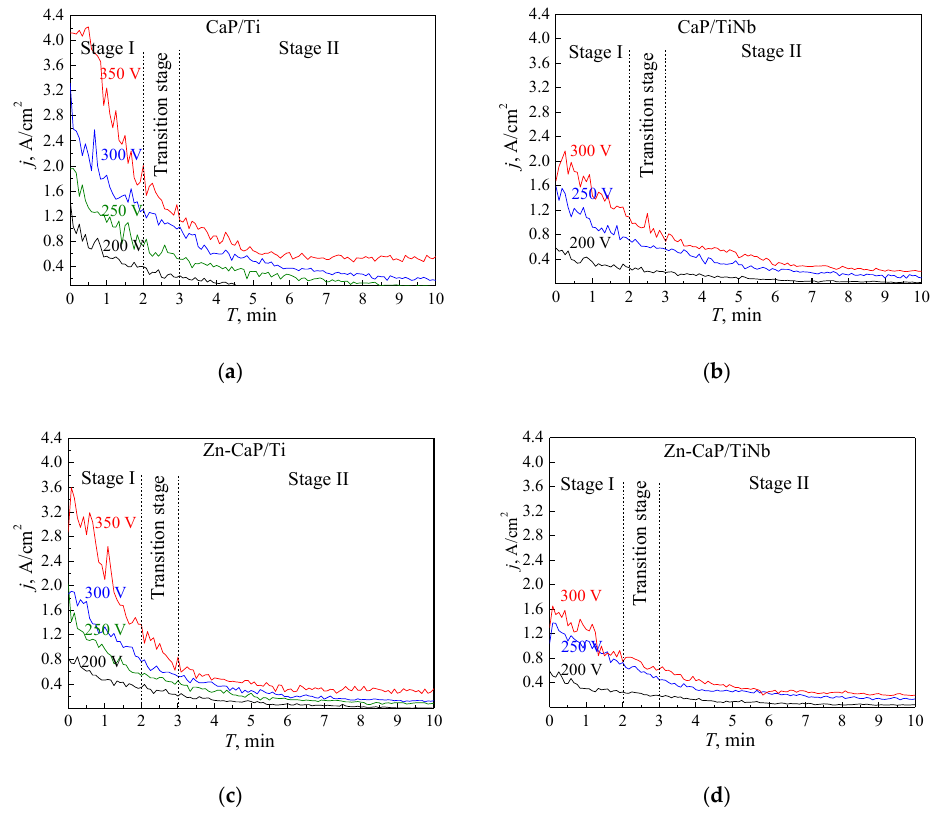
Figure 2. Plots of the current density vs the MAO time for the deposition of the coatings under different applied voltages: ( a ) CaP coating on Ti; ( b ) Zn-CaP coatings on Ti-40Nb; ( c ) Zn-CaP coating on Ti; ( d ) Zn-CaP coating on Ti-40Nb.